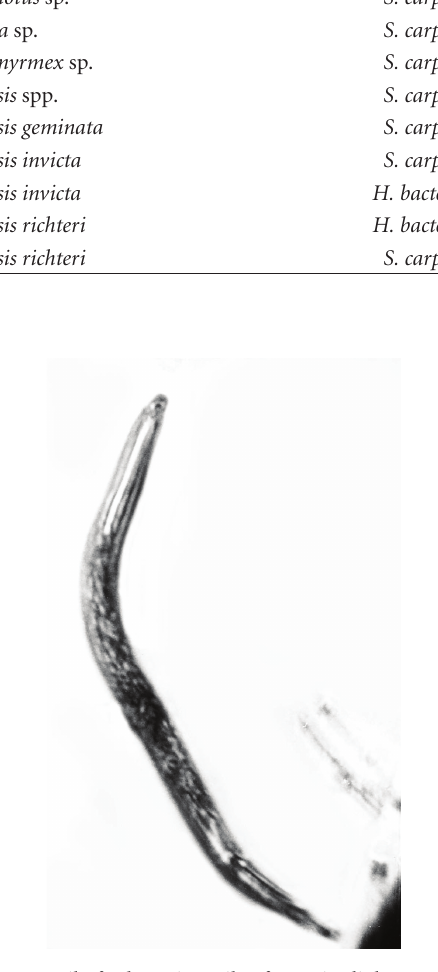
Figure 24: Detail of a dauer juvenile of Formicodiplogaster myrmen- ema adjacent to a worker of Azteca alpha in Dominican amber.